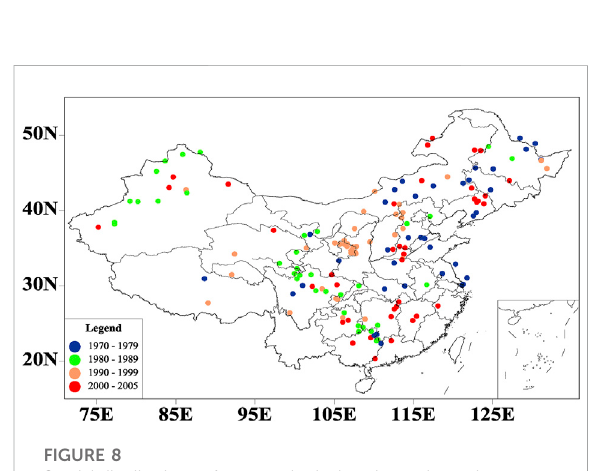
FIGURE 8 Spatial distributions of meteorological stations where abrupt ApEn changes of daily precipitation occurred during 1961 – 2015.